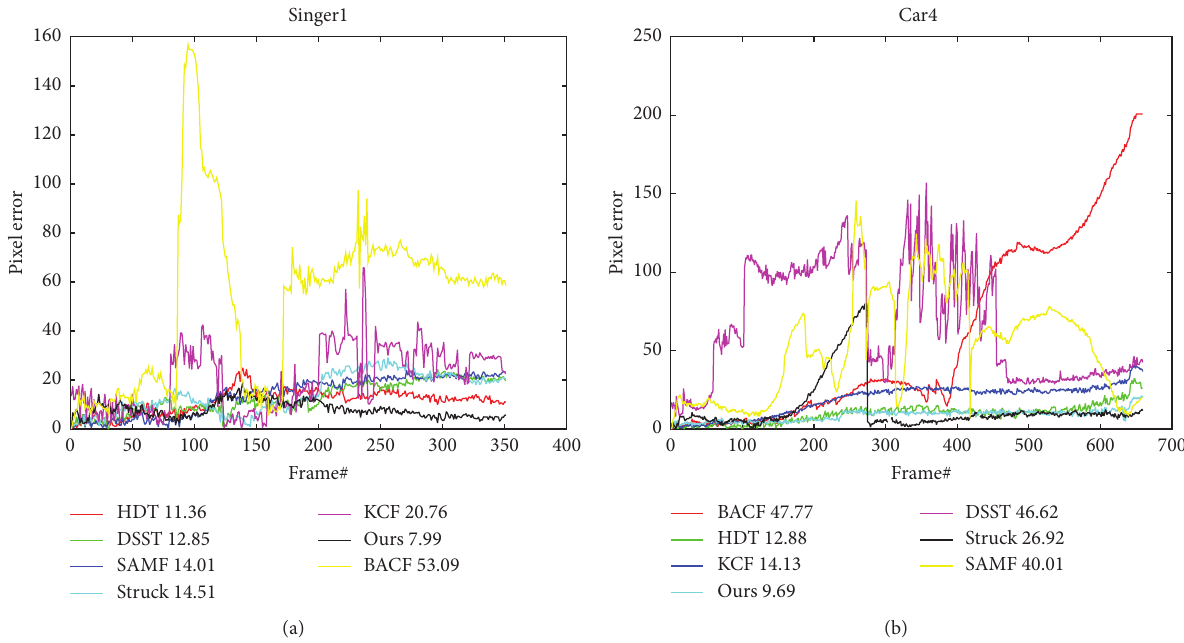
Figure 6: Comparison results of CPE in different test videos. (a) The comparison result of the CPE in Singer1. (b) The comparison result of the CPE in